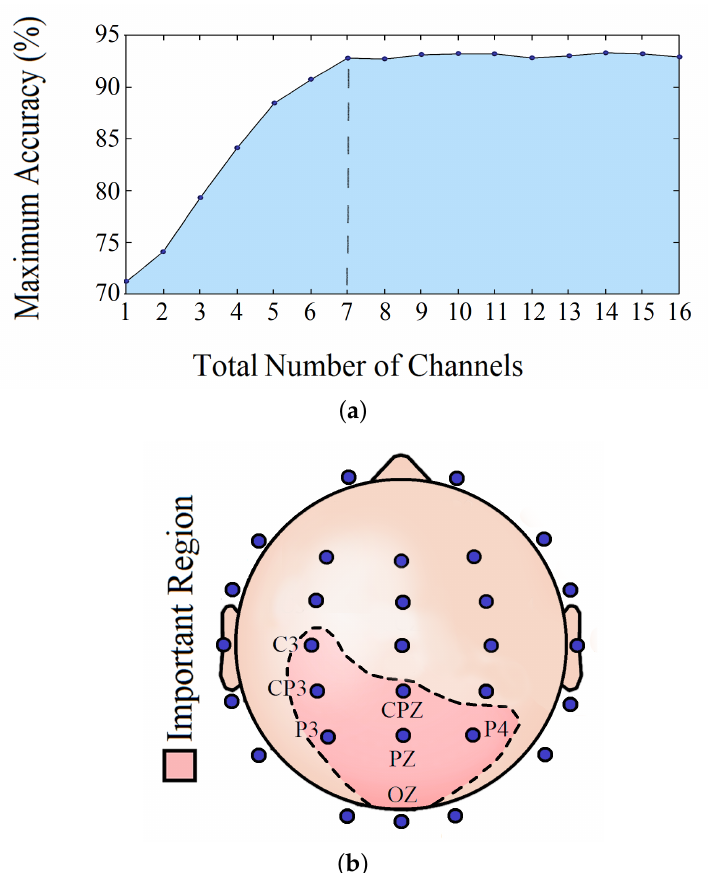
Figure 13. ( a ) Number of channels vs. maximum accuracy and ( b ) 7 most important EEG channels.